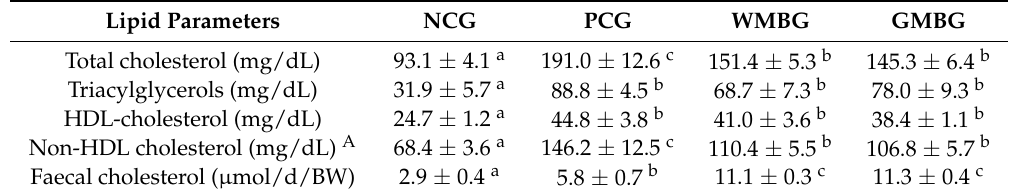
Non-HDL cholesterol (mg/dL) A Faecal cholesterol ( µ mol/d/BW) Mean ± SE. Mean values in lines with different letter superscripts are statistically different at p < 0.05 (ANOVA followed by Tukey’s test). A Non-HDL cholesterol = Total cholesterol − HDL cholesterol.